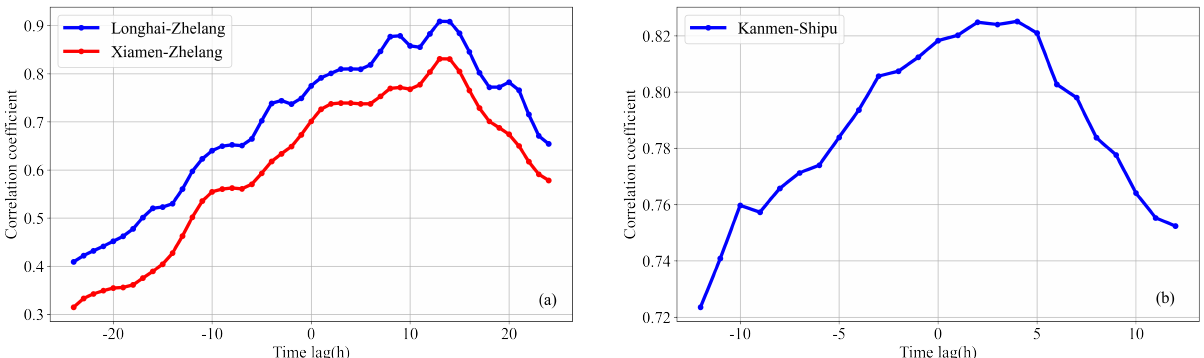
Figure 6. The lagged correlation coefficients between the selected tide gauge stations for ( a ) Xiamen and Zhelang, Longhai and Zhelang, and ( b ) Kanmen and Shipu. The lagged correlation coefficients have a maximum value of greater than